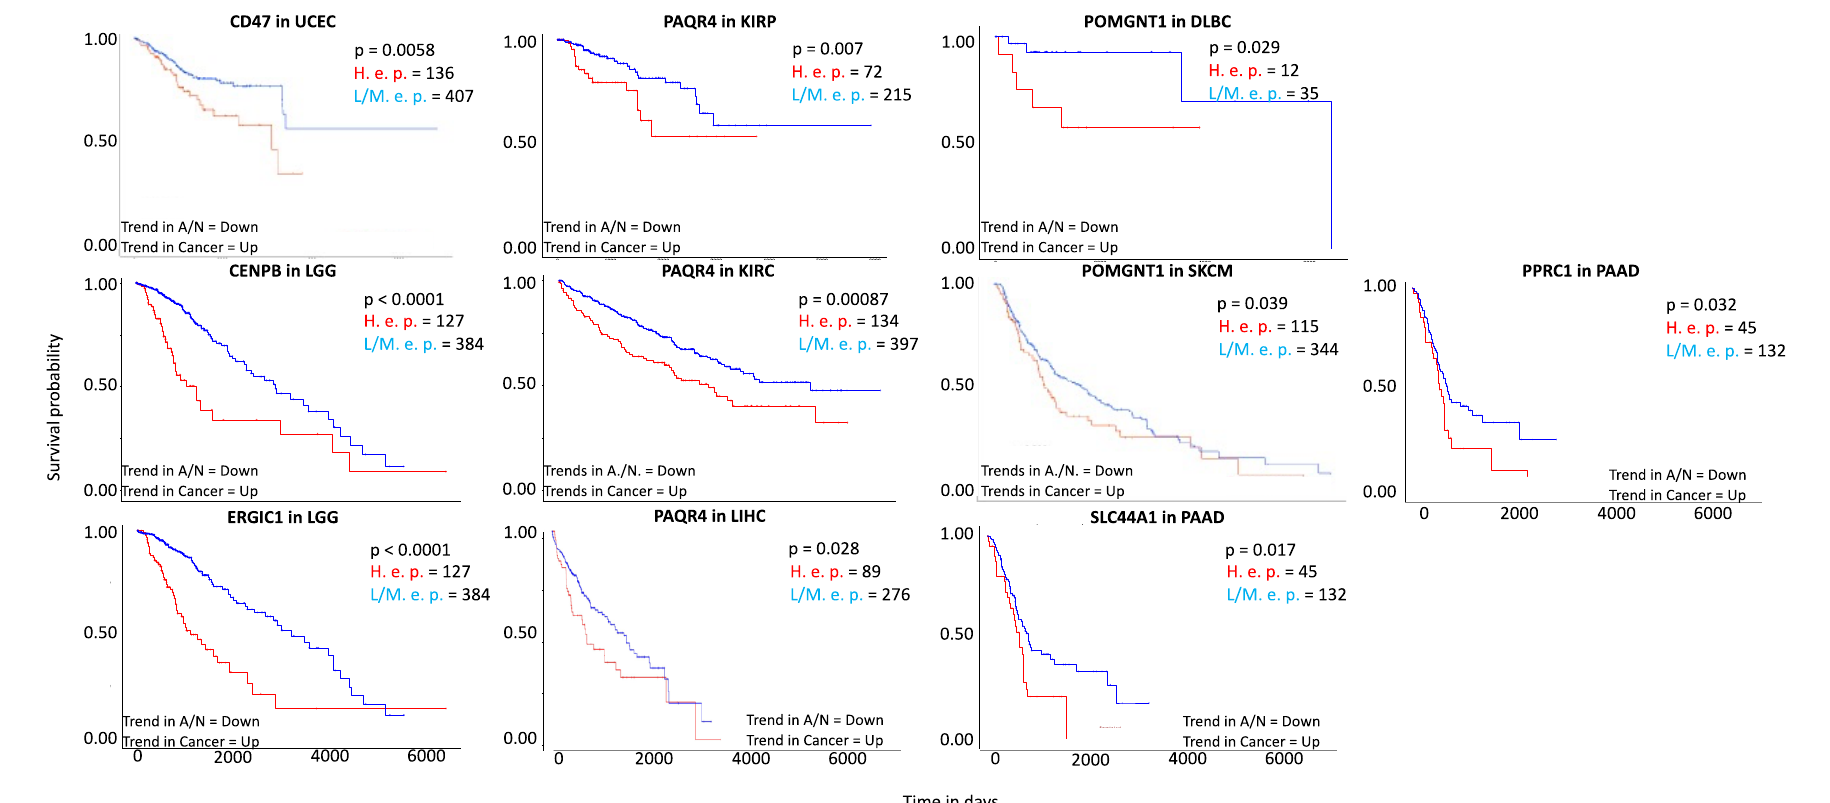
Figure 1. Survival plots (Kaplan–Meier curves) displaying effects of the 7 candidate genes from clinical studies. On the y-axis, the survival probability, and on the x-axis, the time (in days) reported for each considered gene are shown. H. e. p. (High expression patients) and L/M. e. p. (Low/Medium expression patients) indicate the number of patients showing a gene expression value > 3rd quartile and ≤ 3rd quartile, respectively, for each candidate gene. The statistical significance of the difference between the survival curves of H. e. p. and L/M. e. p is p ( p -value by the log-rank test). Trends in apoptotic, nutrigenomic treatments (Trend in A/N) and in cancer (Trend in Cancer) of gene expression (Up- or Down-regulated) are also reported. The plots suggest more favorable outcomes in patients showing the expression trends corresponding to those reported for apoptotic and nutrigenomic treatments. Note: DLBC: lymphoid neoplasm diffuse large B-cell lymphoma, KIRC: kidney renal clear cell carcinoma, KIRP: kidney renal papillary cell carcinoma, LGG: brain lower-grade glioma, LIHC: liver hepatocellular carcinoma, PAAD: pancreatic adenocarcinoma, SKCM: skin cutaneous melanoma, UCEC: uterine corpus endometrial carcinoma.